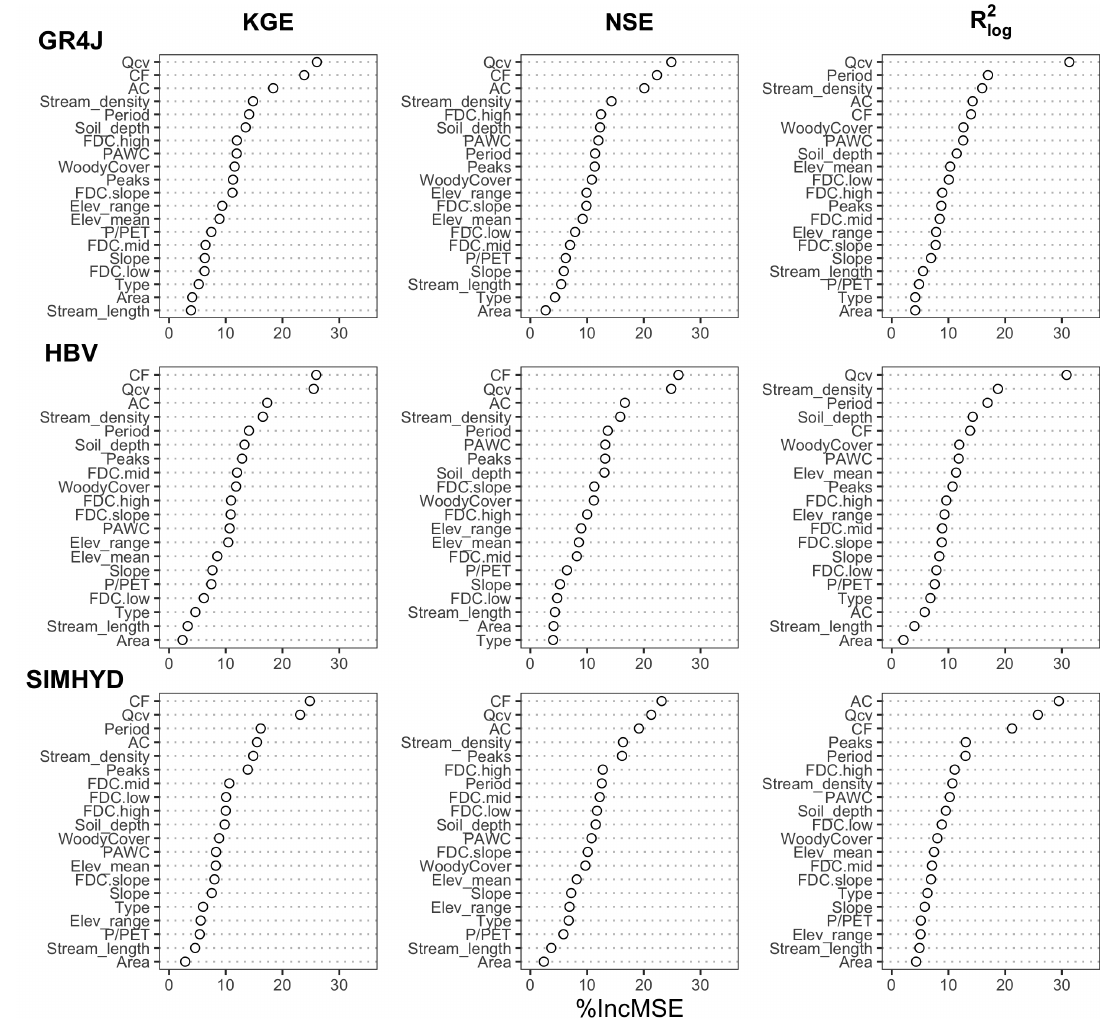
Figure 6. Variable importance in the Random Forest models, as measured by the percent increase in mean squared error in the Out-Of-Bag data, when predicting the Akaike Information Criterion. The models are in rows and the objective functions are in